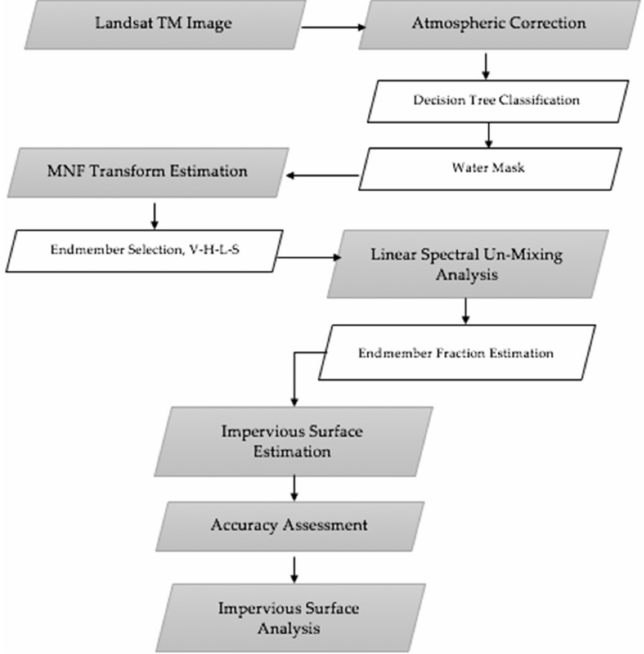
Figure 2. Procedure of impervious surface